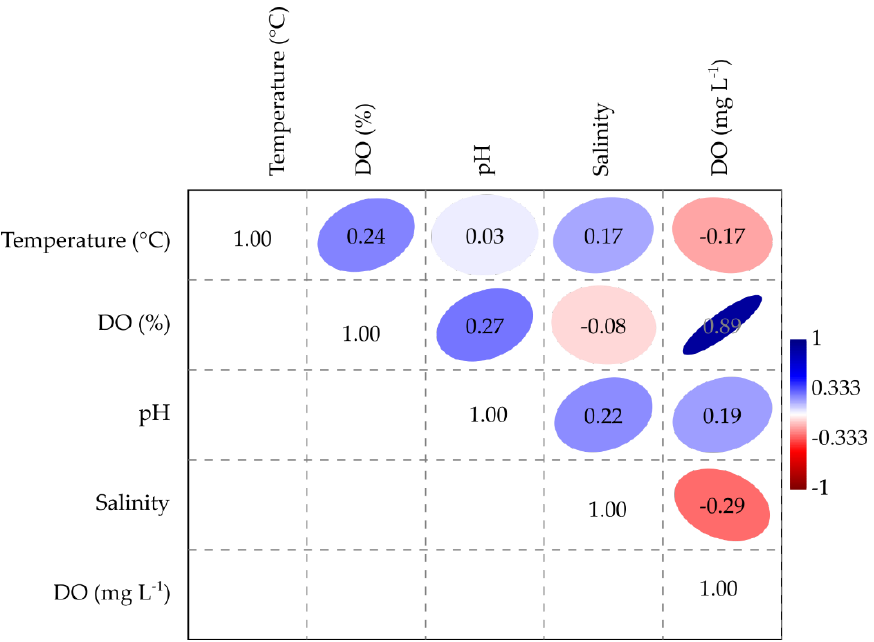
Figure 7. Pearson linear correlations between physico-chemical variables investigated. Color intensity and the shape of the ellipsis are proportional to the correlation coefficients.